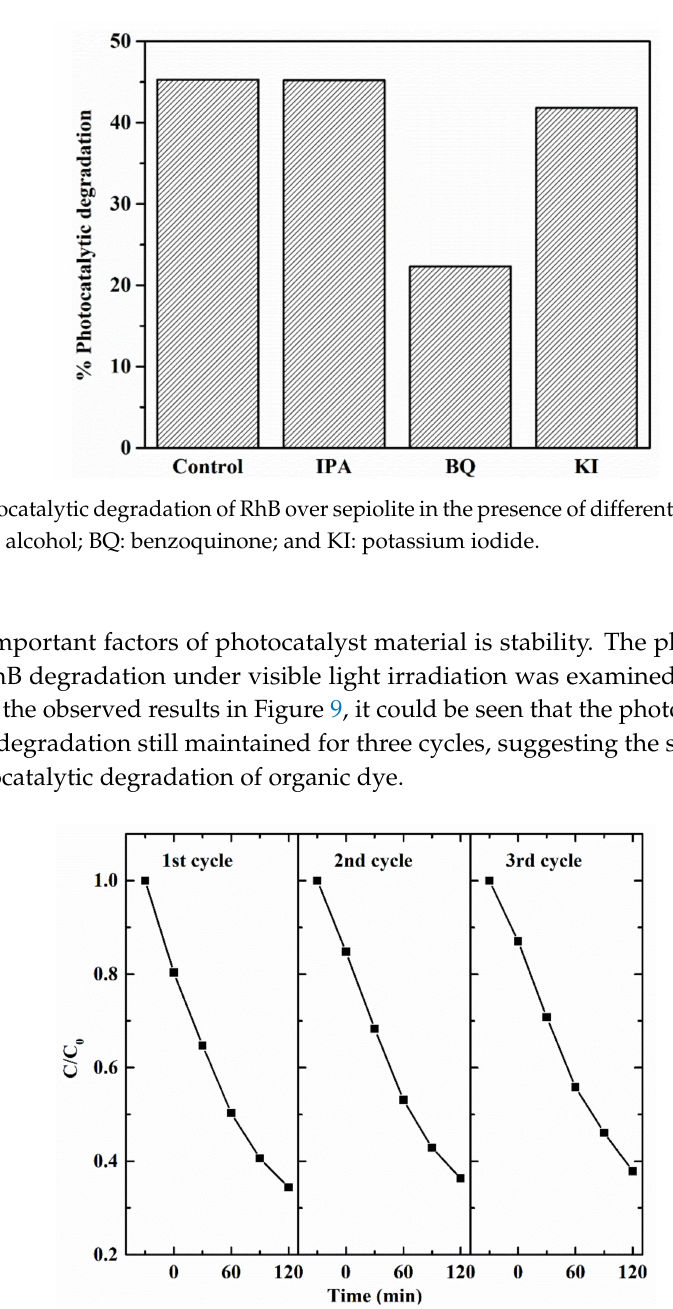
Figure 9. Recycling test in the photocatalytic degradation of 2 × 10 − 5 M RhB over sepiolite (catalyst loading = 0.25 g/L) under visible light